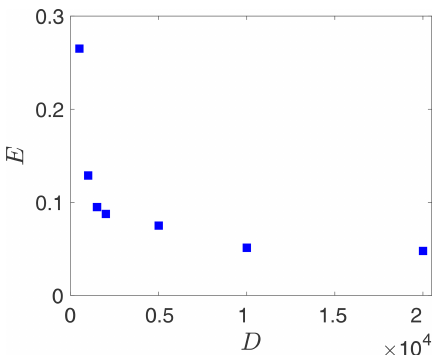
Figure 8. Scaling of average prediction error between 0 and 0 . 5MTU ( E ; Eq. 9) with reservoir size D for RC–ESN. N = 500000 is